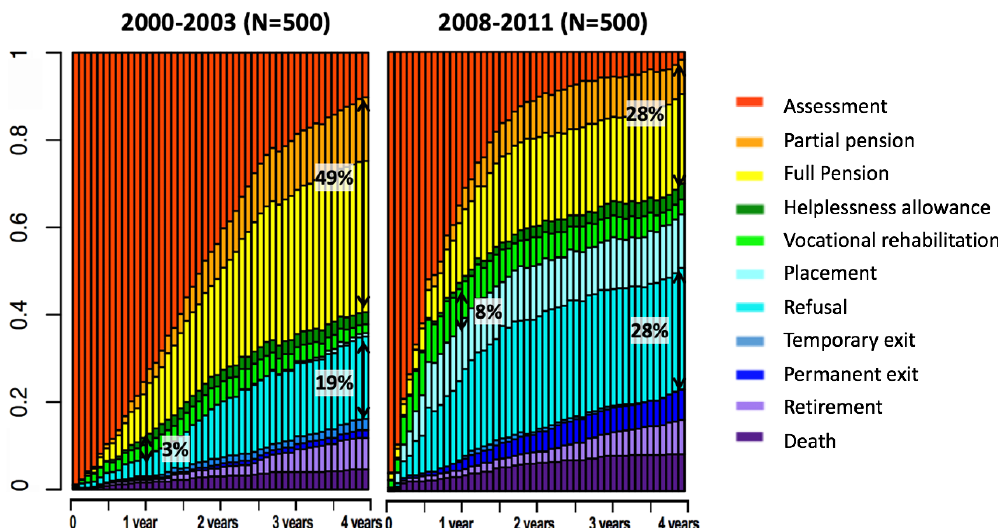
Figure 1. Comparison of two cohorts of DI claimants (2000 and 2008). Source: Rosenstein (2018; computed on the basis of administrative data provided by the DI Office of the canton of